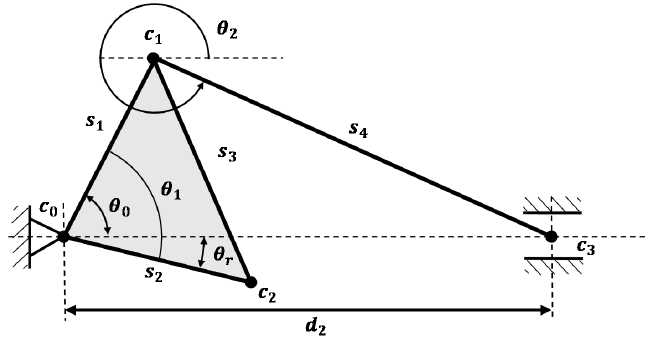
Figure 6. Schematic kinematics of wing root rotation mechanism.